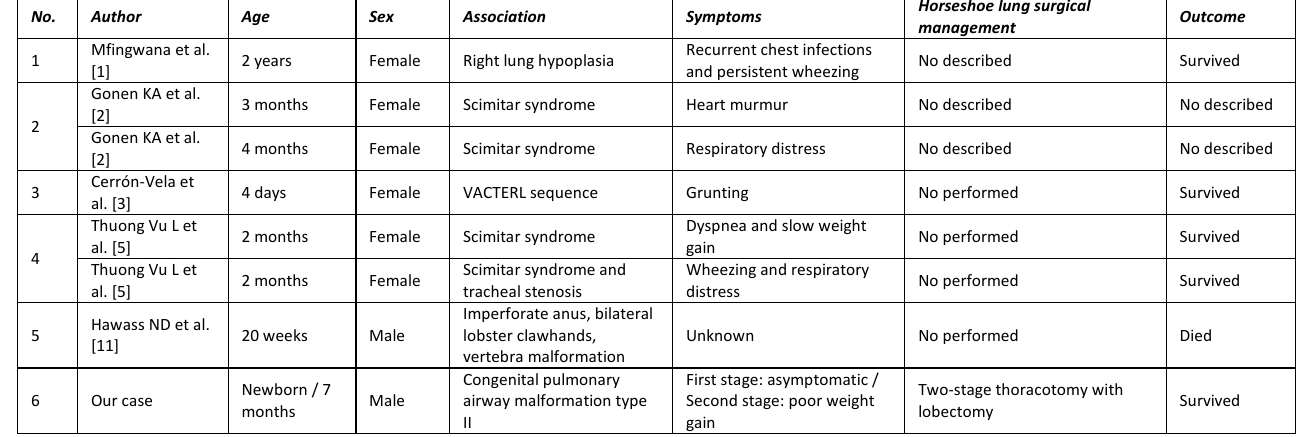
Table 1. Horseshoe lung associated with other congenital